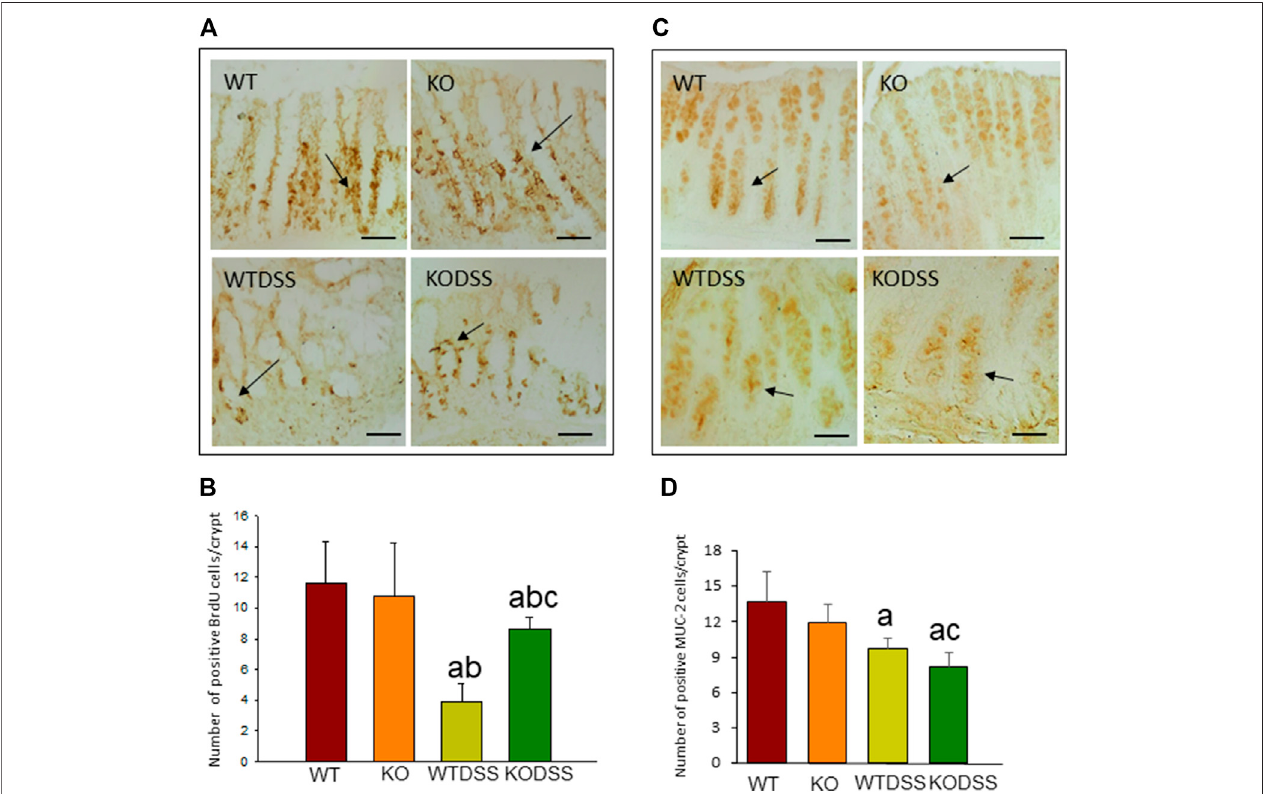
FIGURE 2 | Effect of the DSS treatment on cell proliferation rate and goblet cells in the colon of WT and Gal3KO mice. Representative distal colon sections of cell proliferationrateassessment (A) .ExamplesofBrdU-labelledcellsinthecryptsareindicatedbyarrows.Scalebar (cid:2) 20 µm.Cellproliferationrateexpressedasnumberof BrdU positive cells per colonic crypt (B) ; Representative distal colon sections of stained goblet cells (C) . Arrows indicate MUC-2-labelled goblet cells in the crypts. Quanti fi cation is expressed as the number of MUC-2 positive goblet cells per colonic crypt (D) . Scale bar: 100 µm. Results are mean ± SD of 10 mice per experimental group. Statistical analysis: One-way ANOVA followed by the Fisher ’ s LSD post hoc test for multiple comparisons was used, with α (cid:2) 0.05: (a) , compared withtheWTgroup; (b) ,comparedwiththeKOgroup; (c) ,comparedwiththeWTDSSgroup; p < 0.001forBrdU, p < 0.05forMUC-2.Abbreviations:WT,wildtypemice; WTDSS, wild type mice treated with DSS; KO, Gal3 knockout mice; KODSS, Gal3 knockout mice treated with